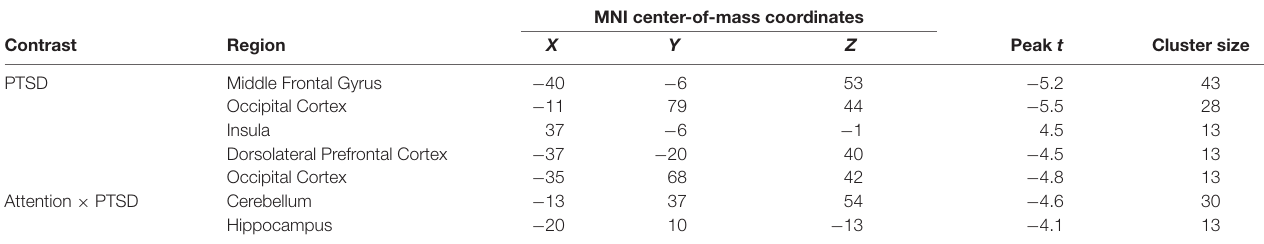
TABLE 3 | Results from the voxelwise LMEM testing group differences in encoding trial-by-trial fluctuations.